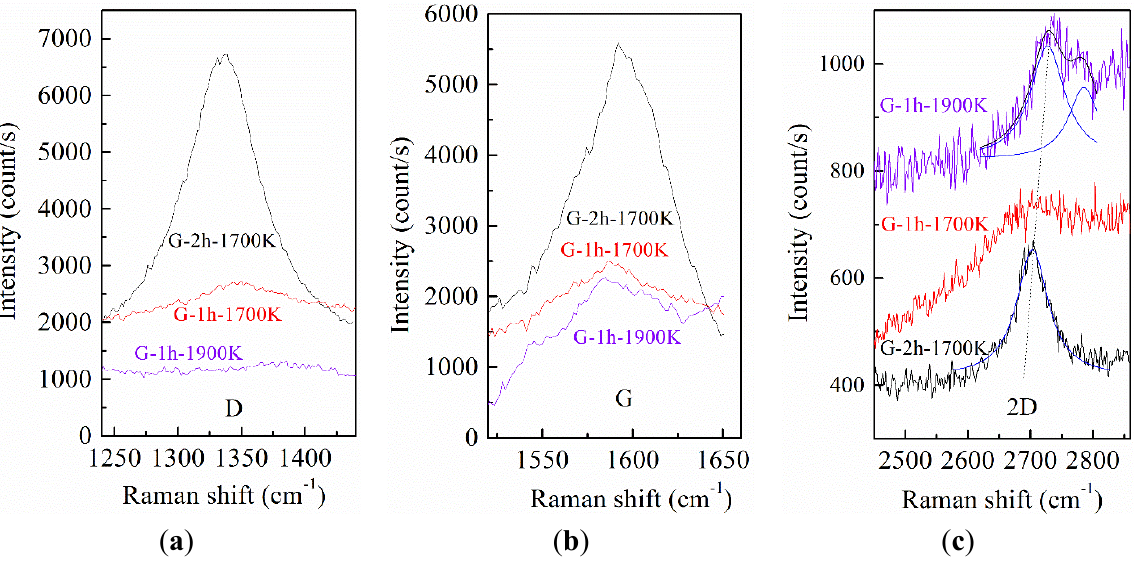
Figure 4. Raman spectra of graphene G-1h-1700K, G-2h-1700K, and G-1h-1900K: